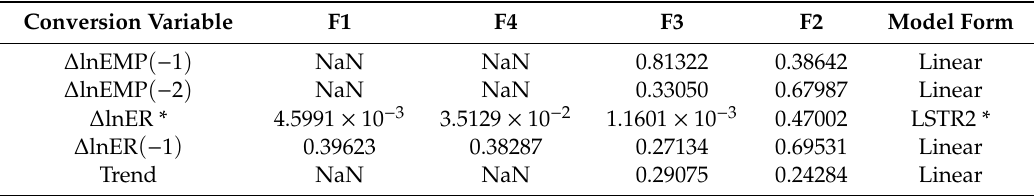
Table 3. Conversion function test selection